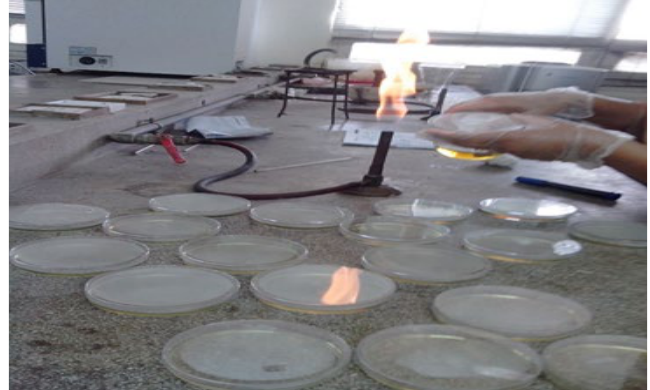
Fig. 3 Oxford Listeria Specific Agar pouring 3.2. Labelling the plates: Labelled all petri plates for streaking and streaked the four sample at one petri plates.